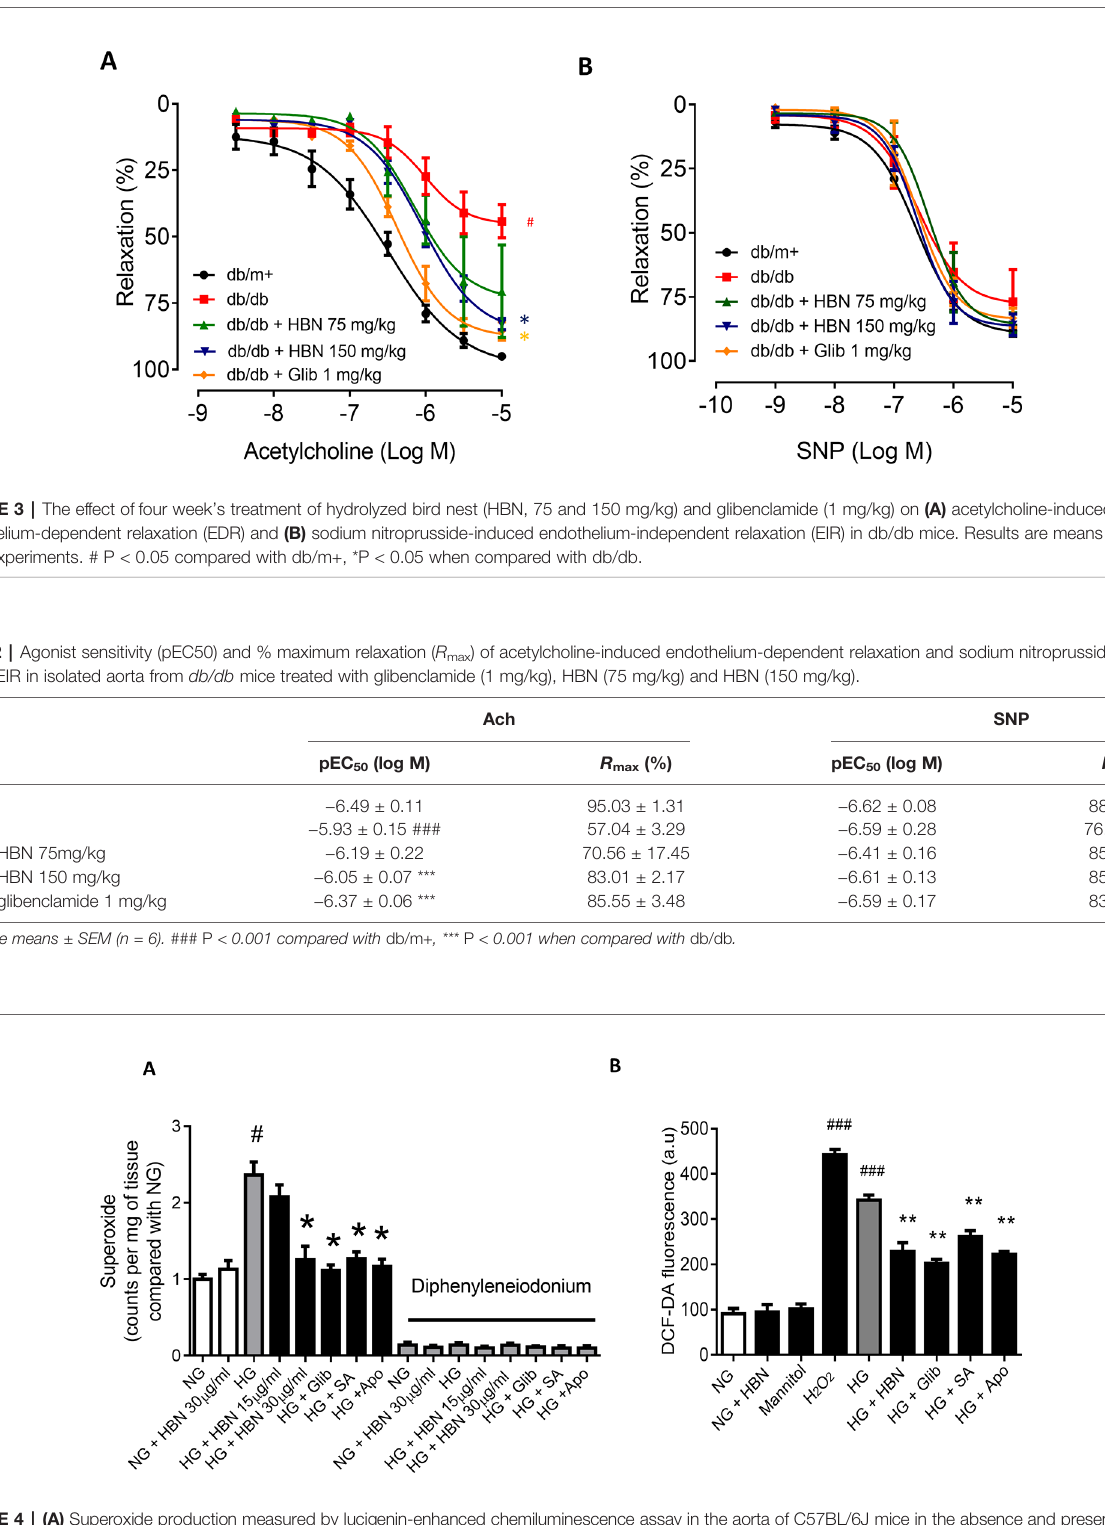
FIGURE 4 | (A) Superoxide production measured by lucigenin-enhanced chemiluminescence assay in the aorta of C57BL/6J mice in the absence and presence of diphenyleneiodonium, NOX inhibitor and (B) level of intercellular ROS measured by DCF-DA assay after treatment with normal glucose (NG, 5 mM), high glucose (HG, 30 mM), mannitol (25 mM), H2O2 (200 µM), calcium ionophore (A23187, 5 µM), Hydrolysed bird nest (HBN, 30 µg/mL), sialic acid (SA, 20 µg/mL), glibenclamide (Glib, 10 µM) and apocynin (Apo, 20 µM) in HUVECs for 48 hours. Results are means ± SEM of 6 independent experiments. # P < 0.05 and ### P < 0.001 compared with NG, *P <0.05 and ** <0.01 compared to HG.